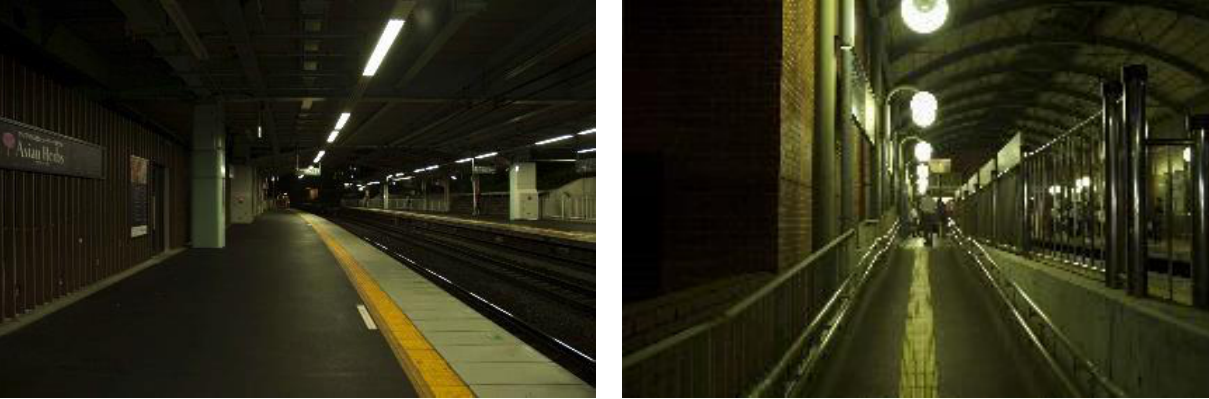
Figure 17. Font view s of the No. 17 ( left ) and No. 19 ( right ) platforms.